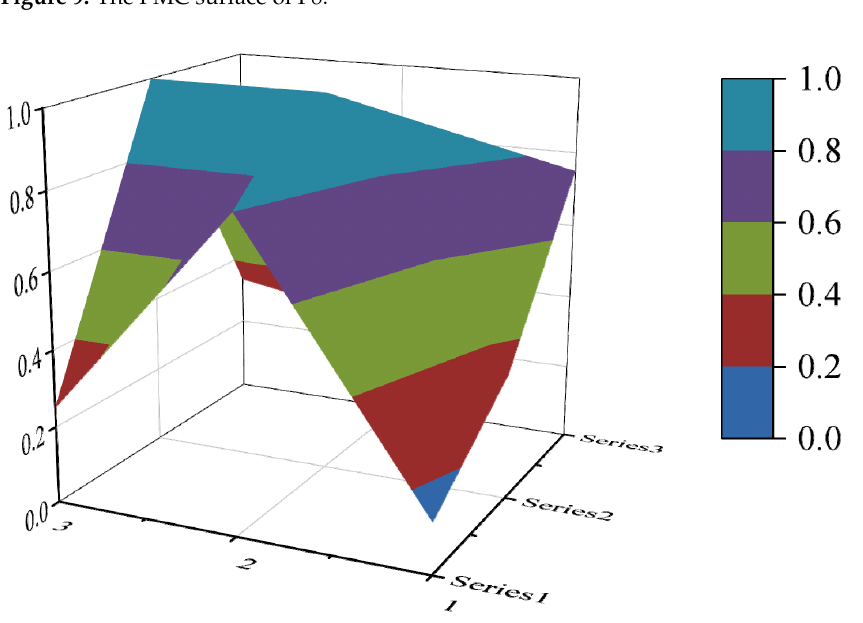
Figure 10. The PMC surface of P9.